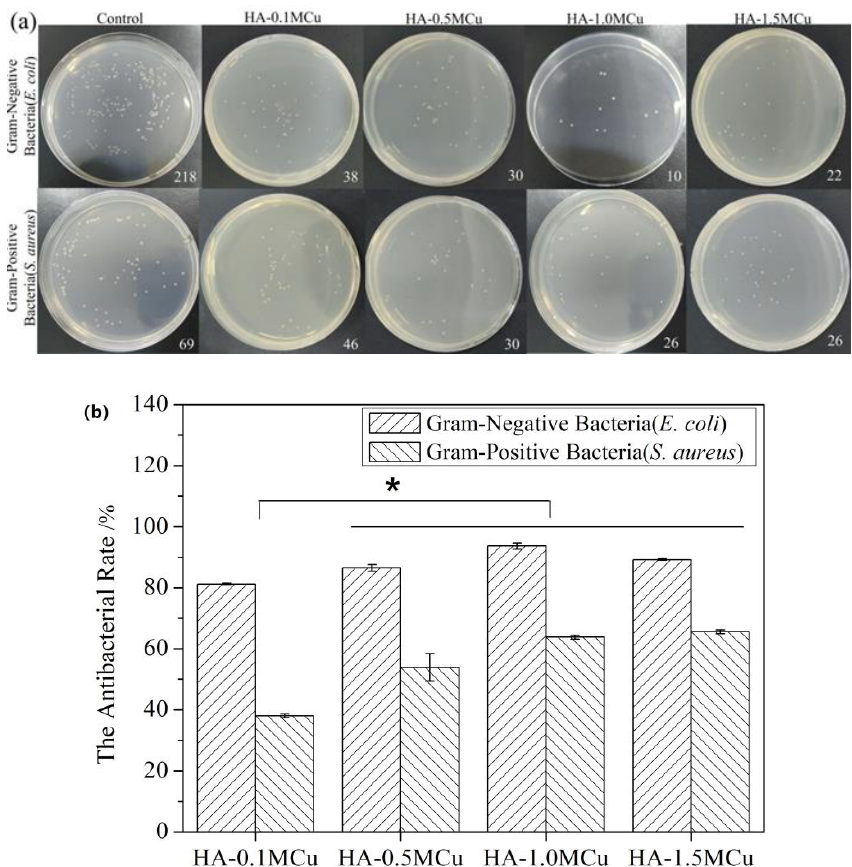
Figure 8. Antibacterial rate against E. coli and S. aureus. (* p < 0.05). ( a ) Plate counting photographs; ( b ) quantitative antibacterial results.